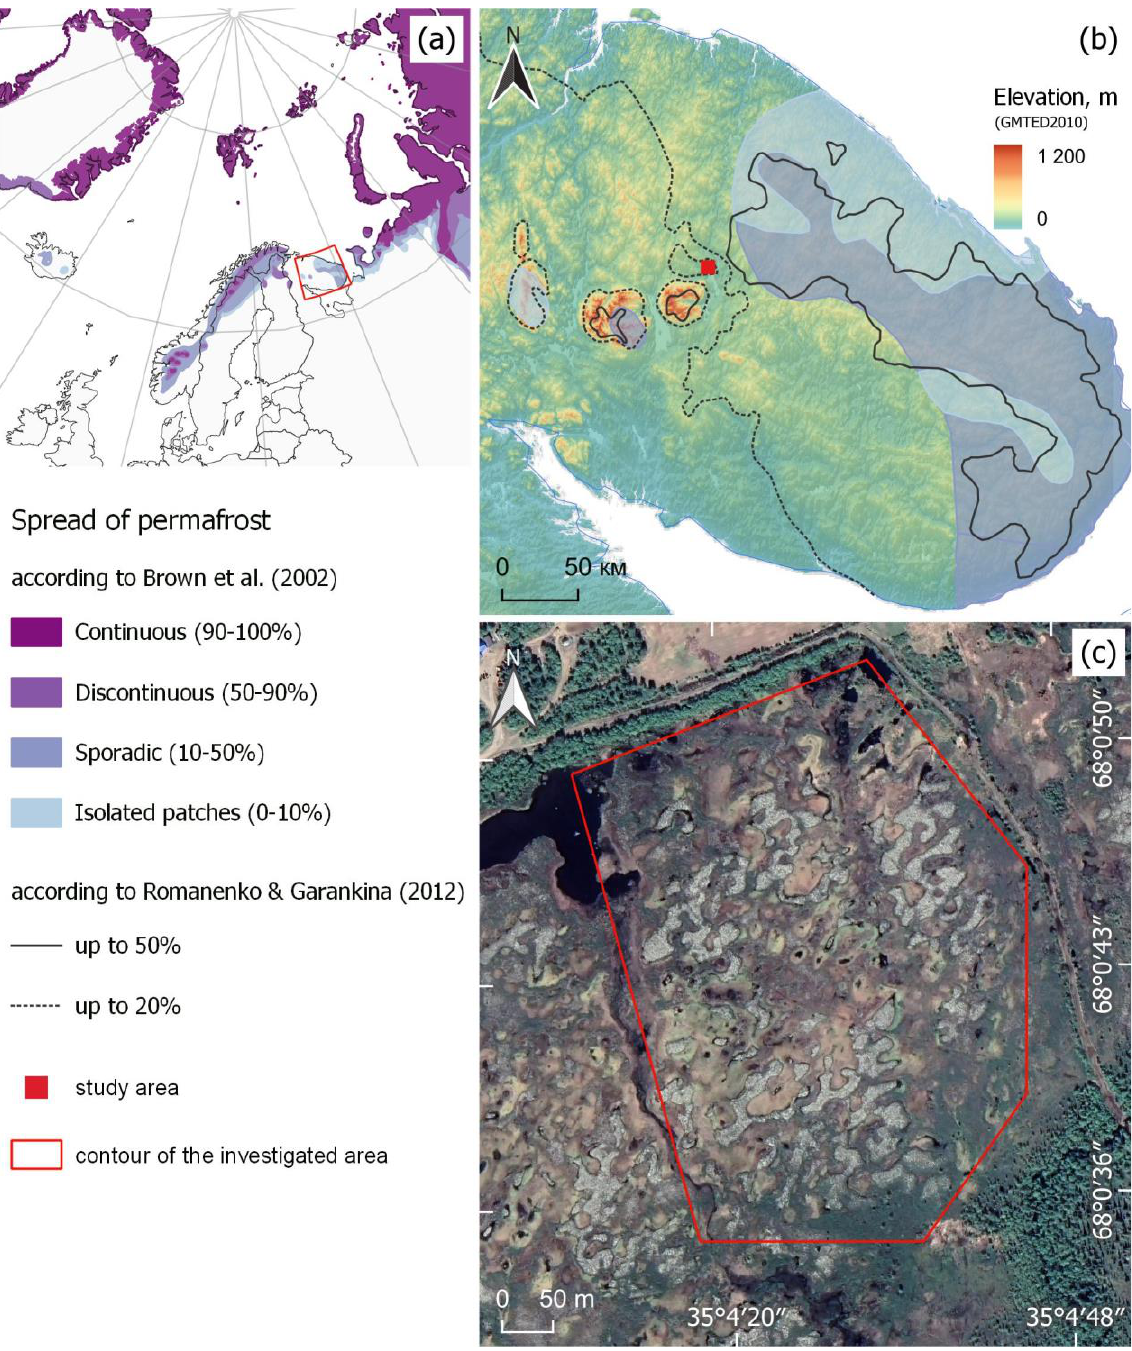
Figure 1. Location of the surveyed palsa mire on the Kola Peninsula, an overview of the distribution of permafrost abundance ( a ), the regional elevation map according to GMTED2010 [52] ( b ), and the site outline on the Google satellite image ( c ). Brown et al. (2002) [26], Romanenko & Garankina (2012) [27].